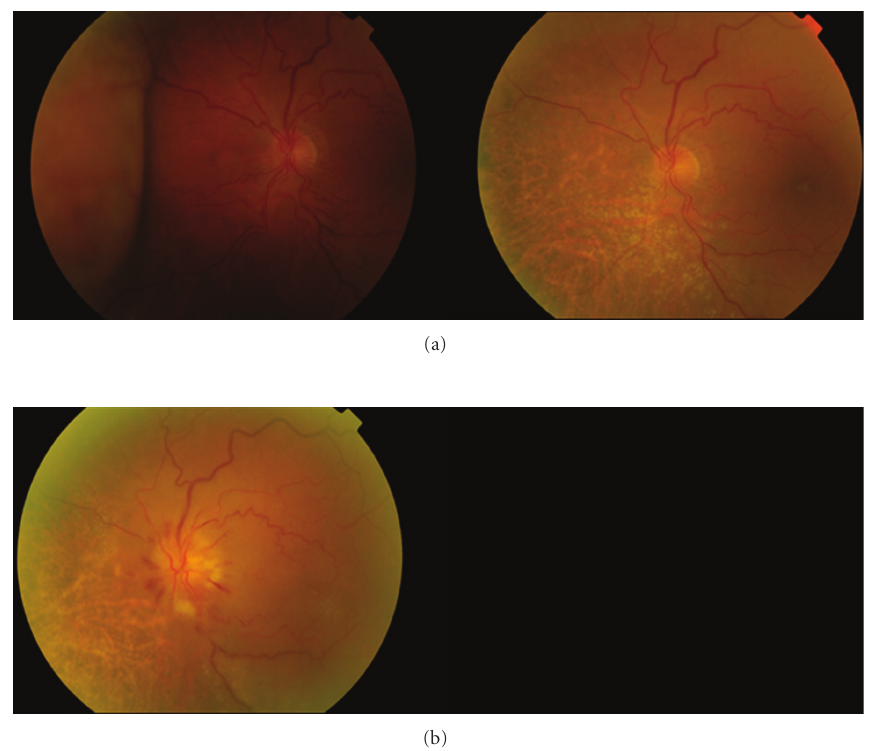
Figure 9: Amelanotic malignant choroidal melanoma treated with plaque brachytherapy. Development of radiation papillopathy and maculopathy one year after